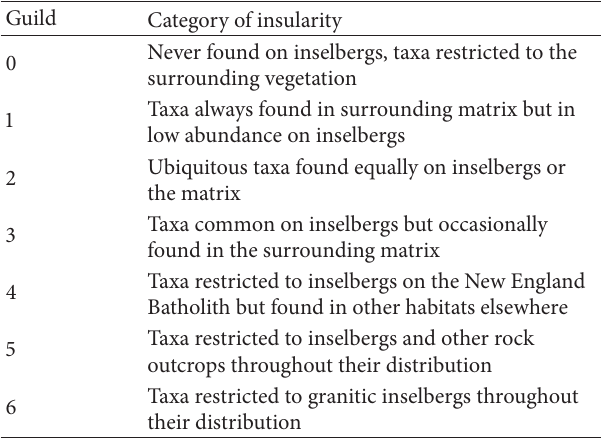
Table 1: Inselberg insular guilds as defined by McGann